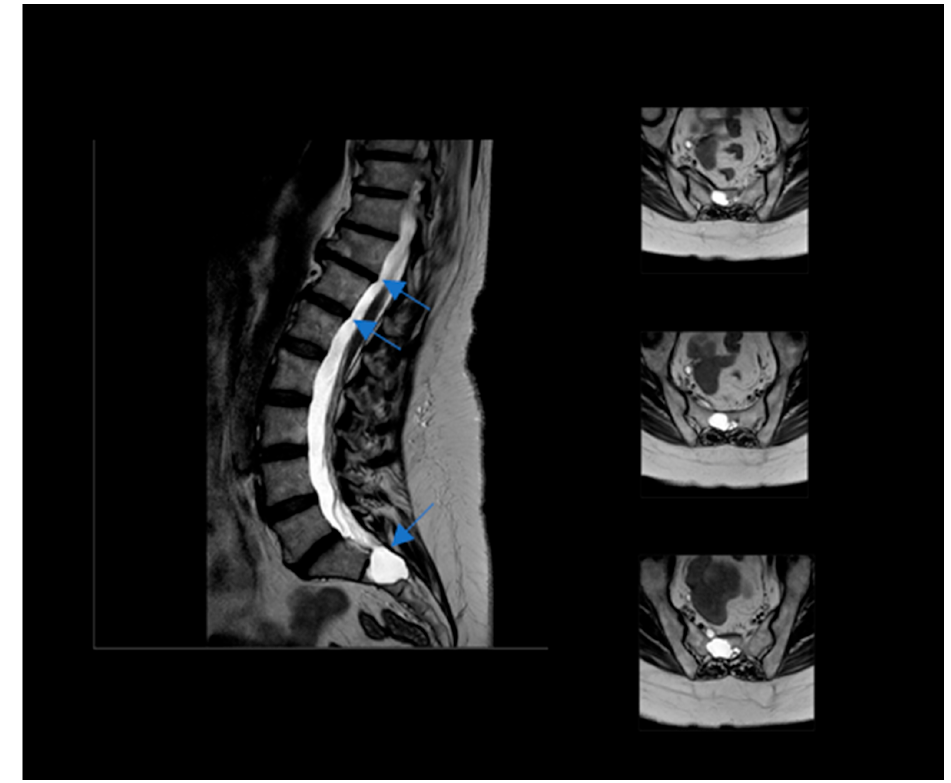
Figure 1. Nuclear Magnetic Resonance of the patient Tarlov’s Cyst indicated by blue arrow.